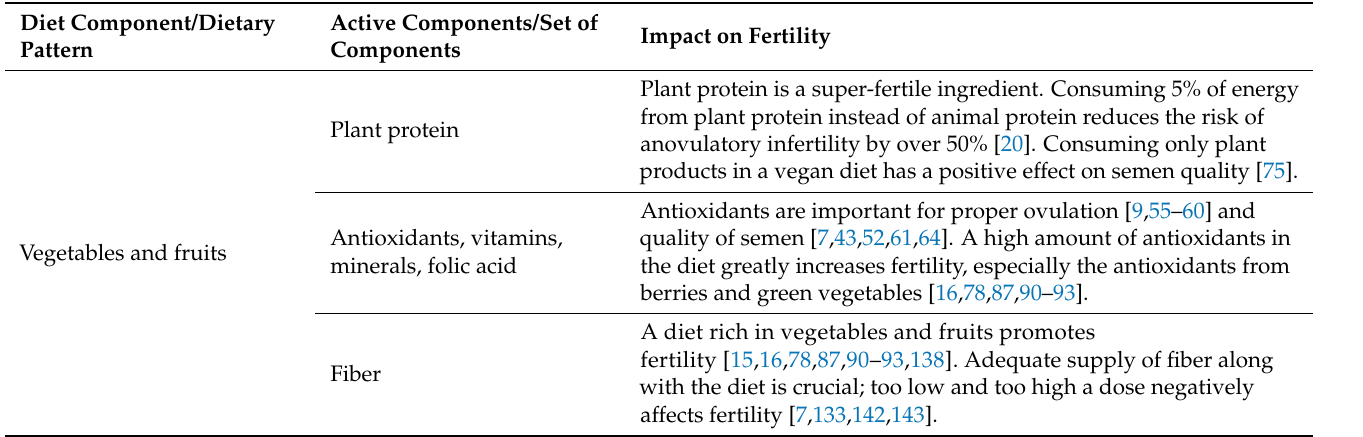
Table 1. Overview of the literature on the relation between diet and